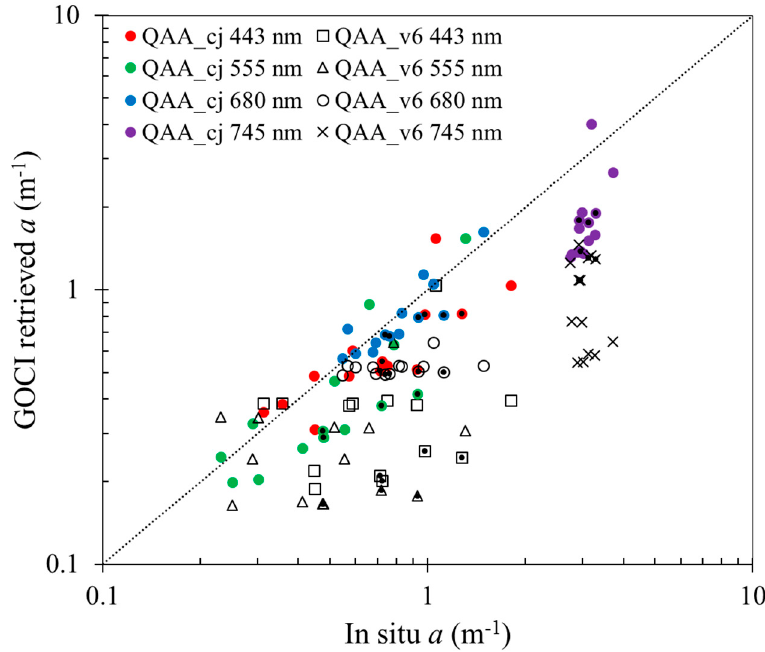
Figure 9. A scattering plot of GOCI retrieved a ( λ ) vs. in situ a ( λ ) data with using the QAA_cj algorithm (filled symbols) and QAA_v6 algorithm (open symbols) at wavelengths of 443, 555, 680, and 745 nm. The symbol with a filled dot inside represents the match point within the time window of ± 3 h.